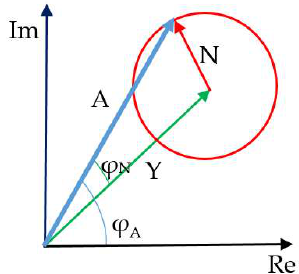
Figure 6. Phasor plot illustrating the amplitude and phase contribution. A is the amplitude of the measured backscatter from one range-cell. N is the sum of the noise and Y the actual backscatter from the reflector. ϕ A is the measured angle and ϕ N the angle of the noise contribution. The red circle illustrates the circular sample space of the noise.